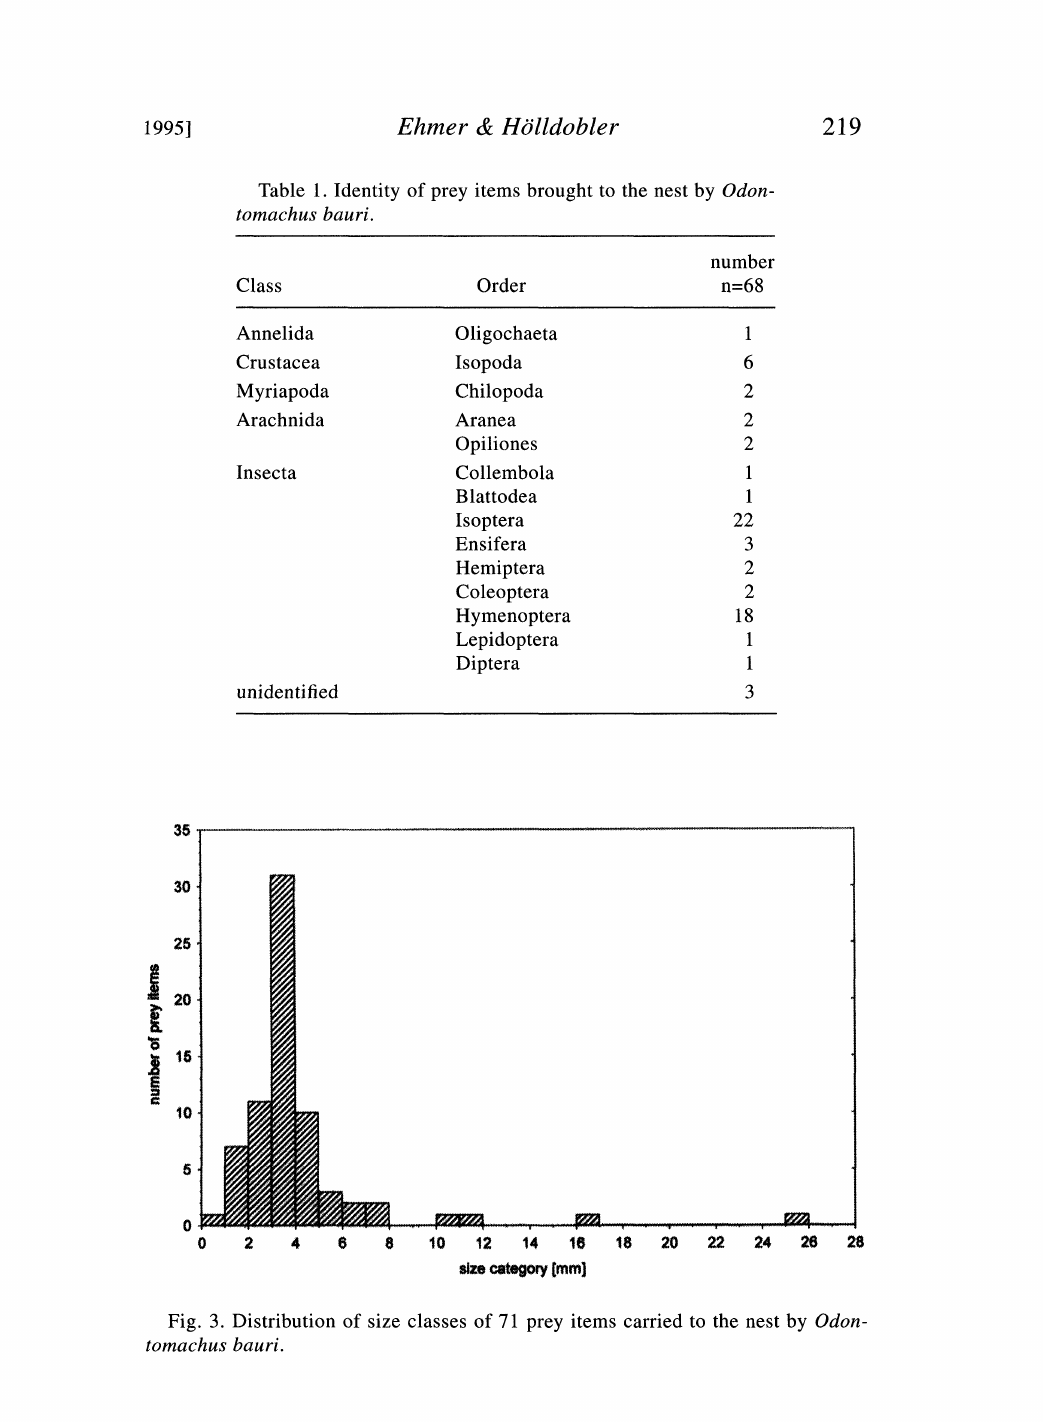
Fig. 3. Distribution of size classes of 71 prey items carried to the nest by Odon- tomachus